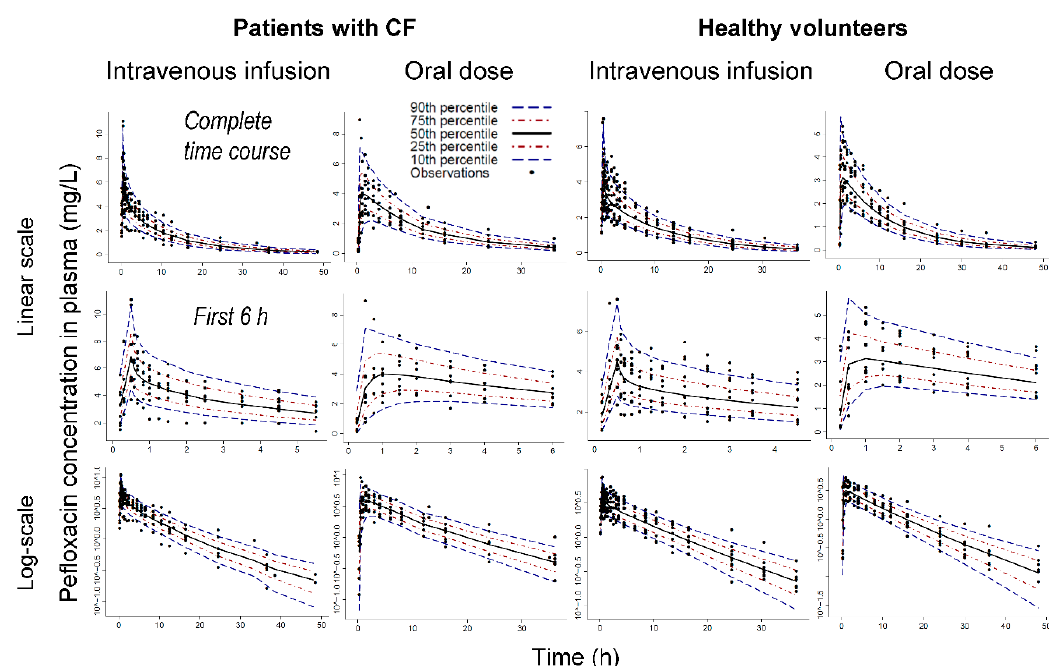
Figure 3. Visual predictive check for pefloxacin plasma concentrations in patients with CF (left) and healthy volunteers (right). The two top rows show plasma concentrations over the complete time course (first row) or during the first 6 h (second row), whereas the third row displays concentrations on logarithmic scale. The plots show the observations (markers), the 50th percentile (i.e., median) of the model predictions (black line) along with the 80% prediction interval [10th to 90th percentile] and the interquartile range [25th to 75th percentile]. Ideally, the median should capture the central tendency of the observations and 10% of the observations should fall outside the 80% prediction interval on either side.